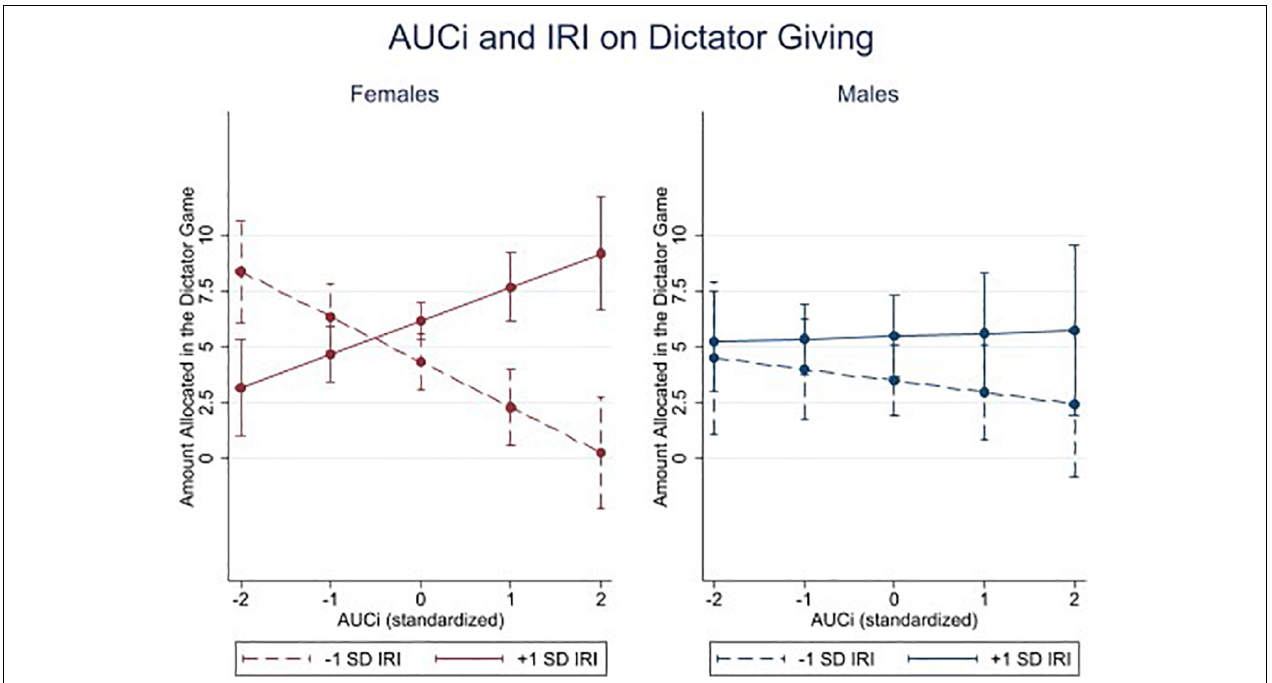
FIGURE 2 | Area under the curve with respect to increase (AUCi) and interpersonal reactivity index (IRI) on dictator giving. Amount transferred in the dictator game as a function of cortisol reactivity (Area under the curve with respect to increase, standardized to mean = 0 and SD = 1). The figure shows the predicted amount transferred in the Dictator Game for females (left, N = 60) and males (right, N = 63). Lines represent marginal means for individuals 1 SD above (solid) or below the mean (dashed) in empathy. Bars represent 95% confidence